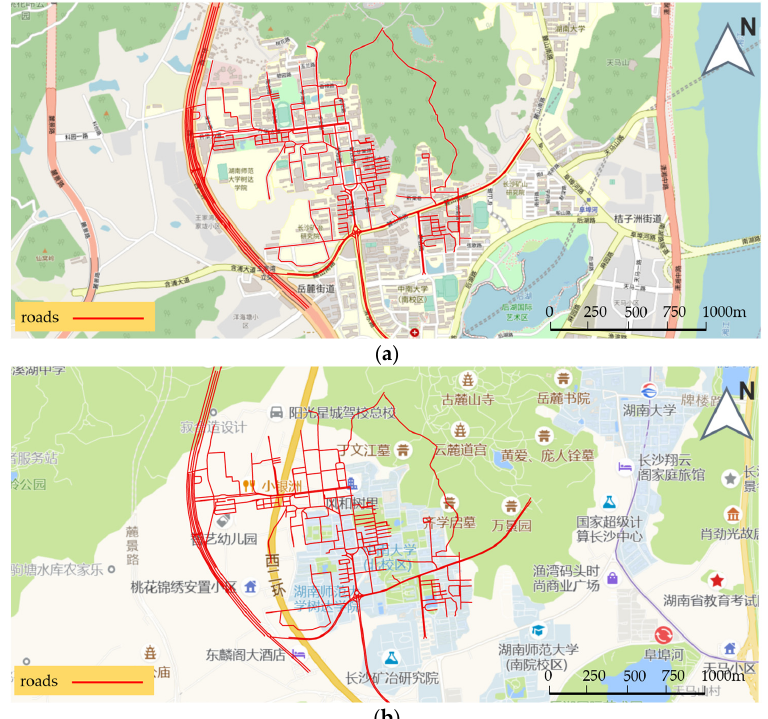
Figure 8. Vector data of CSU with di ff erent base map. ( a ) Vector data of CSU with Open Street Map as the base map. ( b ) Vector data of CSU with Amap as the base map.